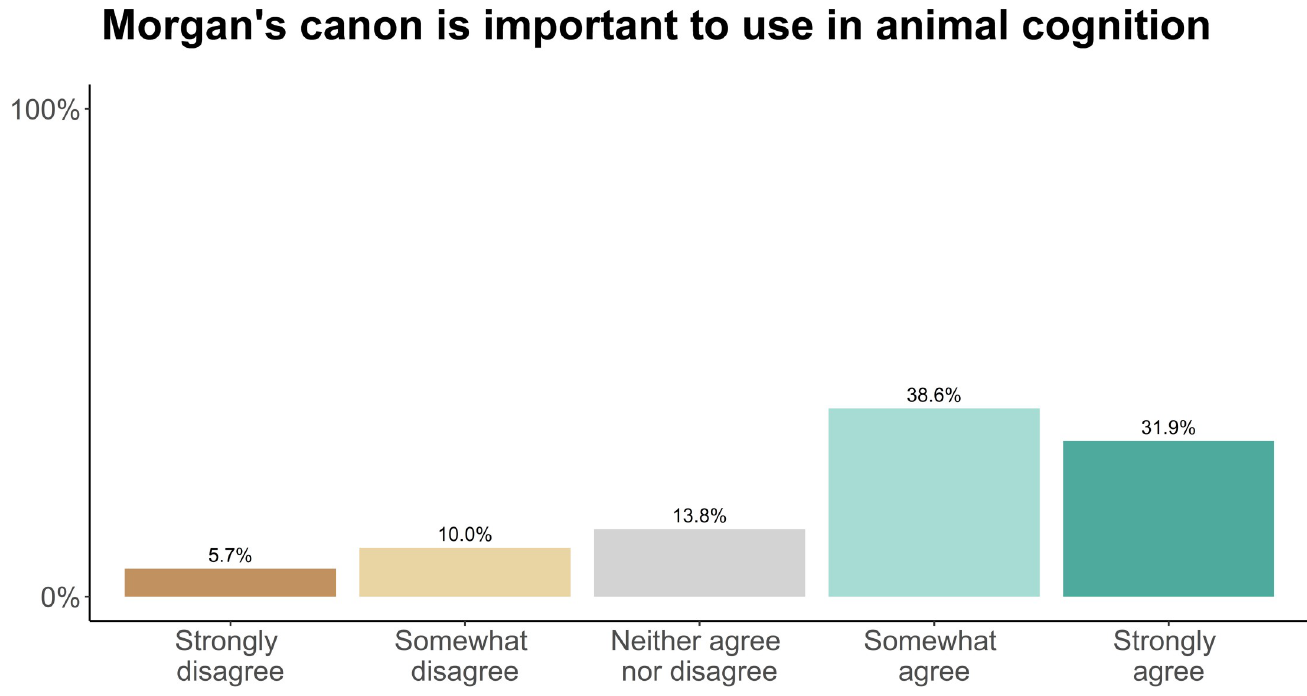
Fig 8. Animal cognition researchers’ endorsement of Morgan’s canon (N = 210).